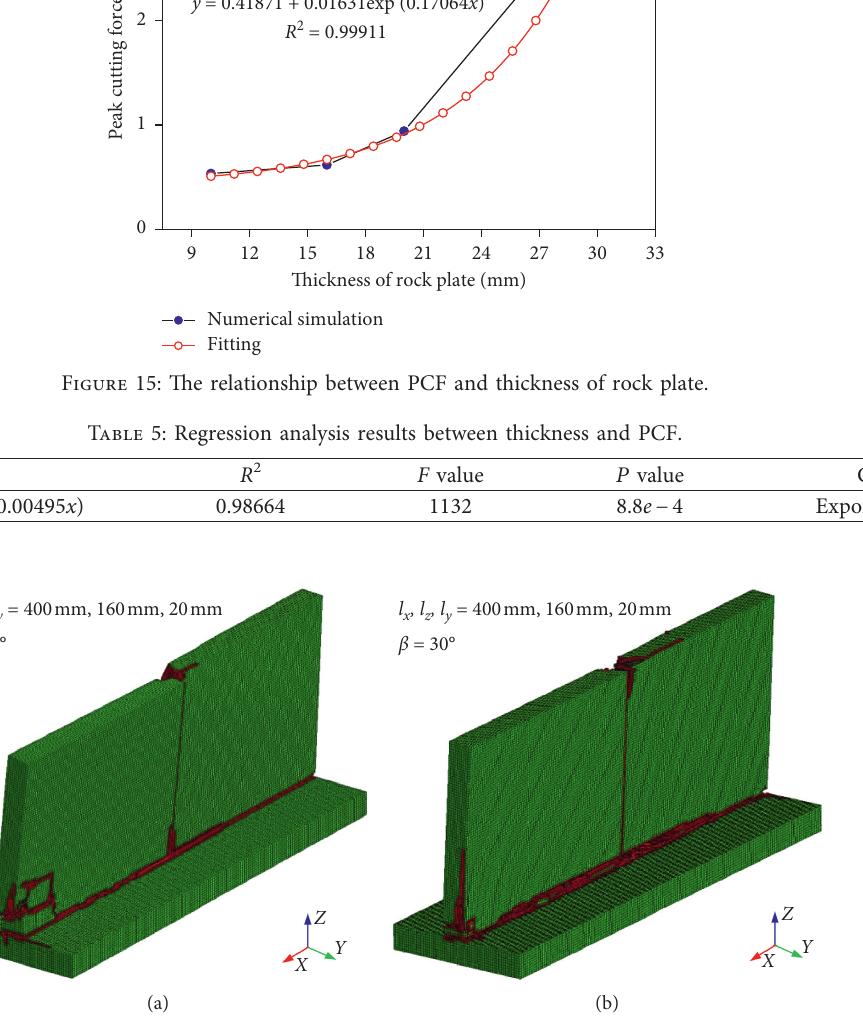
Figure 16: Numerical results of rock plates with different cutting angles: (a) β � 10 ° and (b) β � 30 °